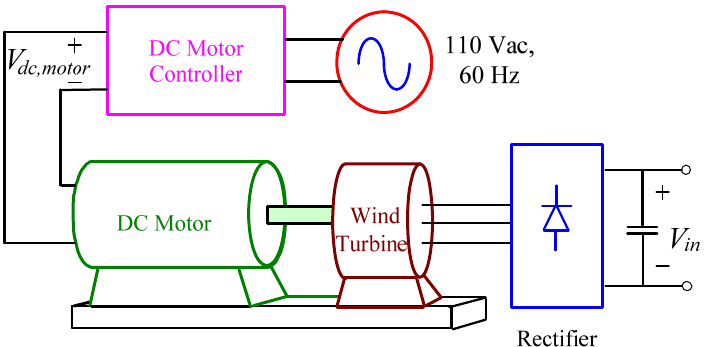
Figure 10. The emulator simulation system for the wind energy